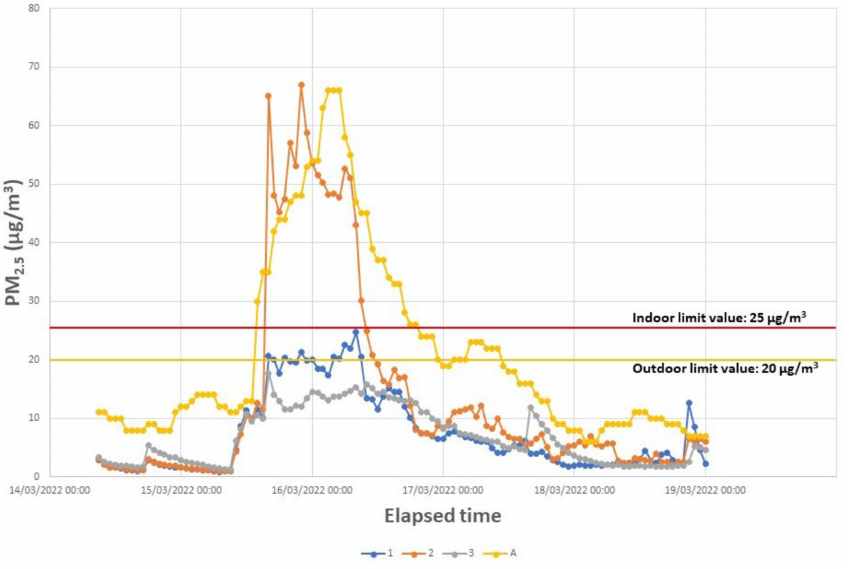
Figure 6. Recorded indoor PM 2.5 concentrations in buildings 1, 2, and 3, and station A (outdoor) from 14 to 19 March